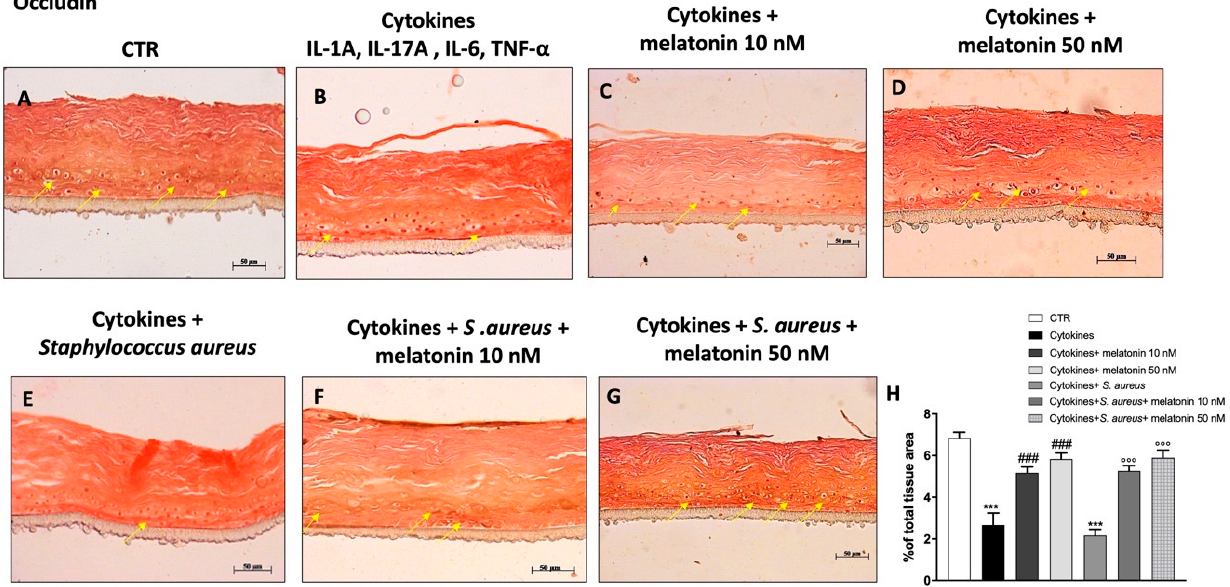
Figure 6. Effect of melatonin on occludin expression. Immunohistochemical staining revealed that the cytokines and S. aureus group were characterized by a progressive decrease of occludin expression compared to the control ( A , B , E ). The treatment with melatonin 10 nM and 50 nM significantly restored its expression, almost to basal levels( C , D , F , G ). The yellow arrows indicate the positive staining. Data are representative of at least three independent experiments. ( H ) *** p < 0.001 vs. CTR; ### p < 0.001 vs. cytokines group; °°° p < 0.001 vs. cytokines+ S. aureus group.